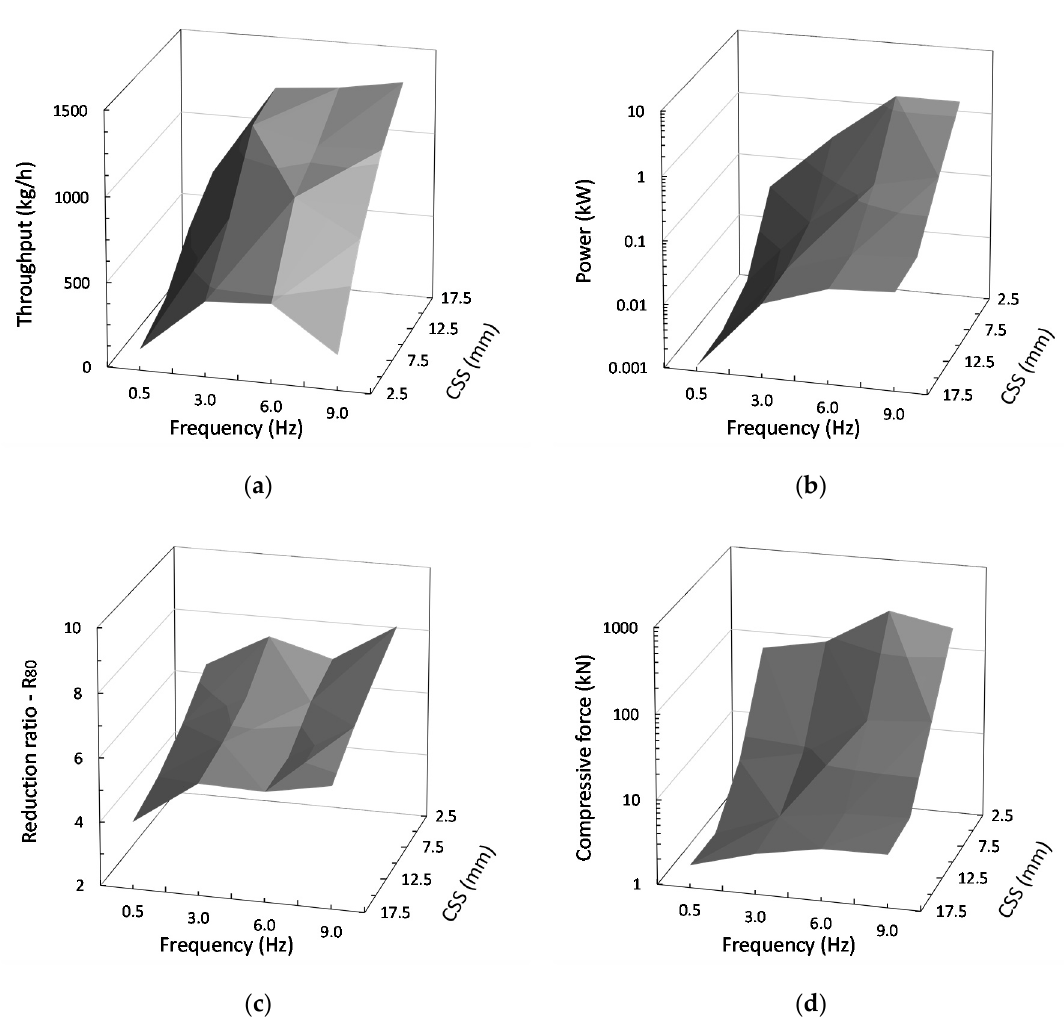
Figure 17. Response surface analysis of the jaw crusher DEM simulations showing throughput ( a ), power ( b ), reduction ratio ( c ) and compressive force ( d ) as a function of closed side setting (CSS) and stroke frequency.